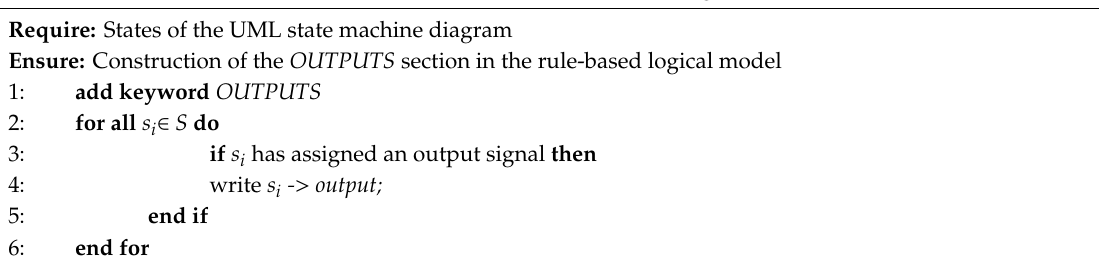
Algorithm 5. Generation of the OUTPUTS section in the rule-based logical